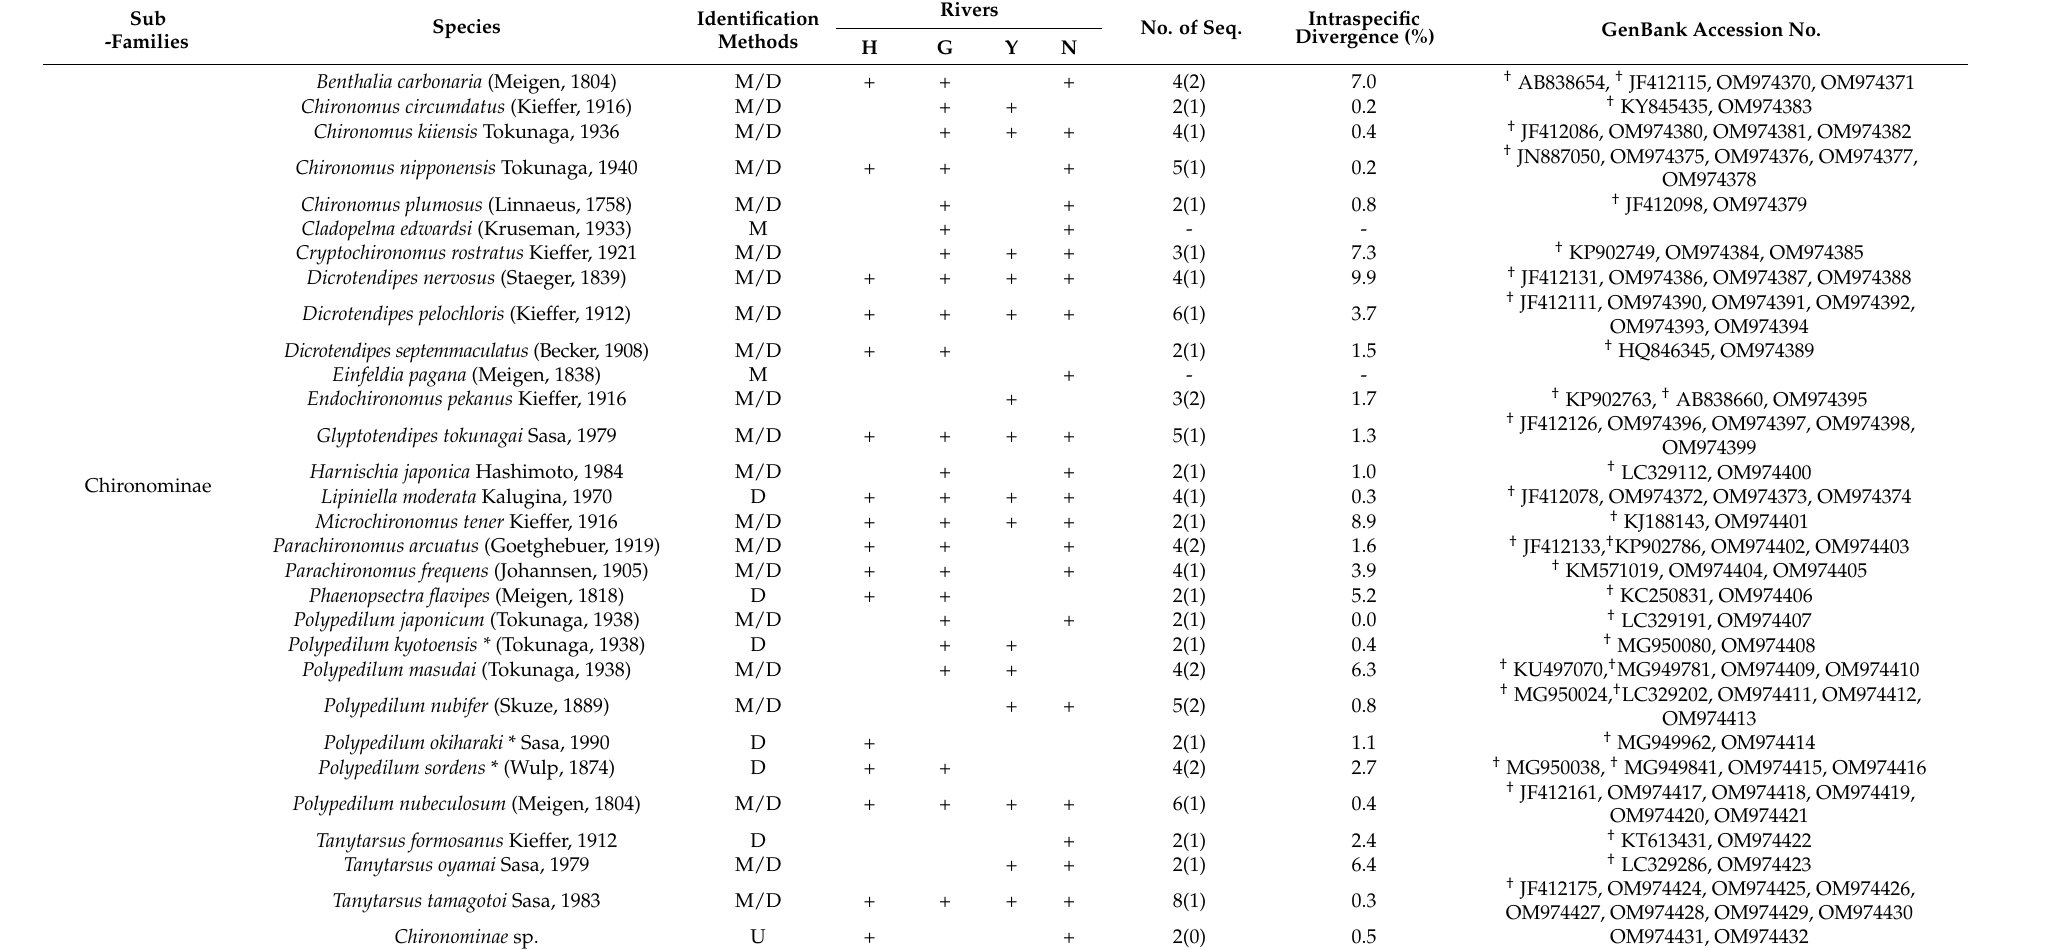
Rivers No. of Methods